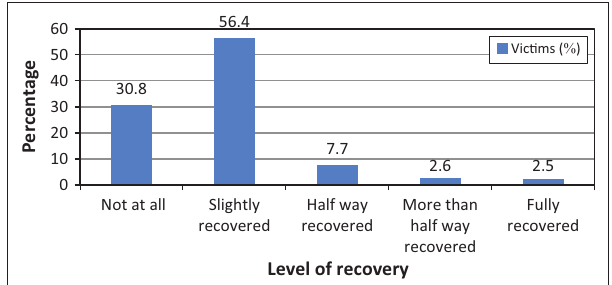
FIGURE 1: Level of recovery 7 weeks after the Babessi floods.